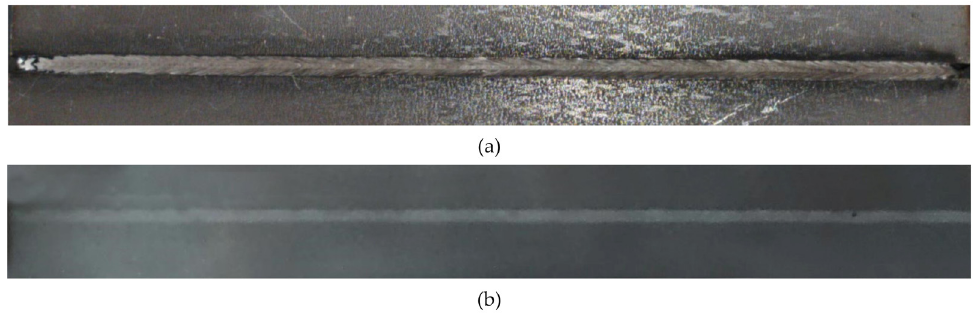
Figure 8. Appearance ( a ) and X-ray ( b ) of the sample